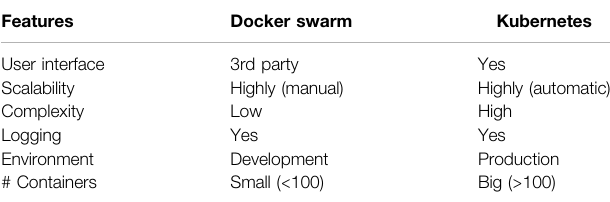
TABLE 2 | Comparison of orchestration technologies for Big Data infrastructure developmentanddeployment.Thefeaturecategoriesarechosenwithrespect to the identi fi ed necessities in the infrastructure